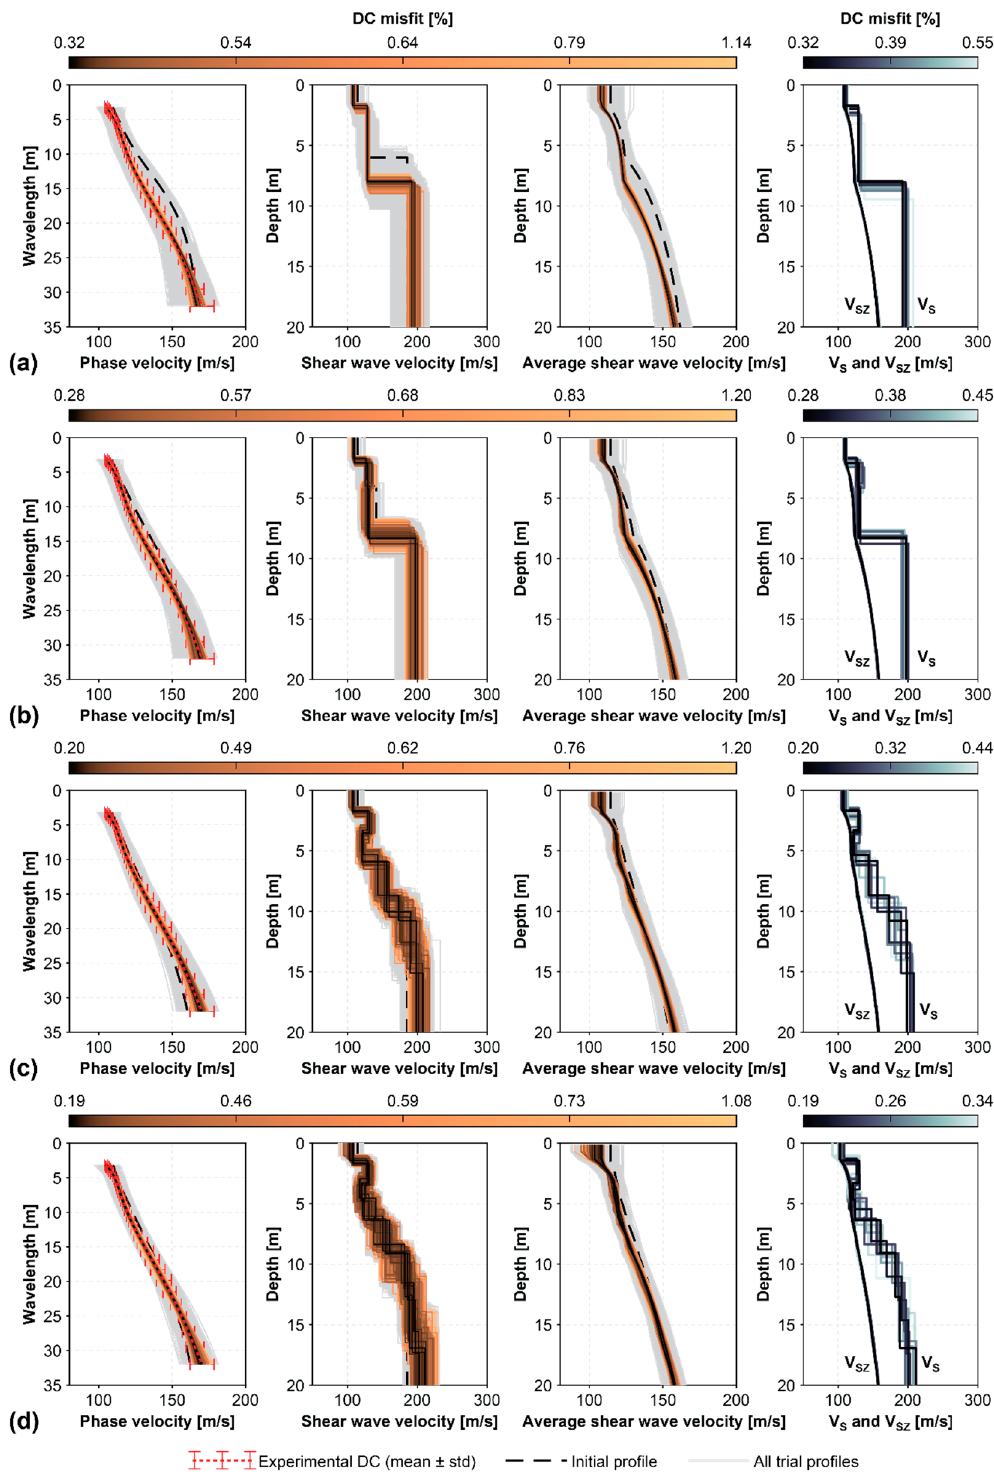
Figure 19. Inversion of the composite dispersion curve for the Halden site. A geologic structure consisting of ( a ) three, ( b ) four, ( c ) six and ( d ) eight layers (incl. the half-space) was assumed. Profiles whose corresponding dispersion curves fall within one standard deviation of the composite experimental curve are presented using a color scale. The lowest dispersion misfit V S - and V SZ -profiles within each independent set of 1000 iterations are shown in column furthest to the right.